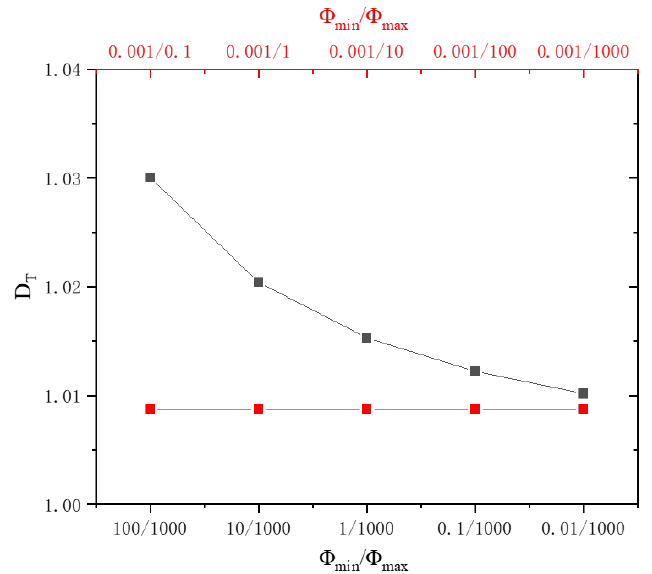
Figure 8. The influence of the pore diameter distribution on the tortuous fractal dimension.